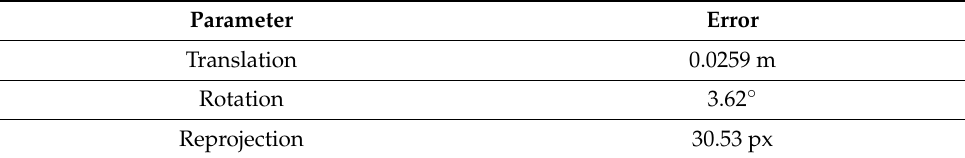
Table 6. Error in the LiDAR-camera calibration process.